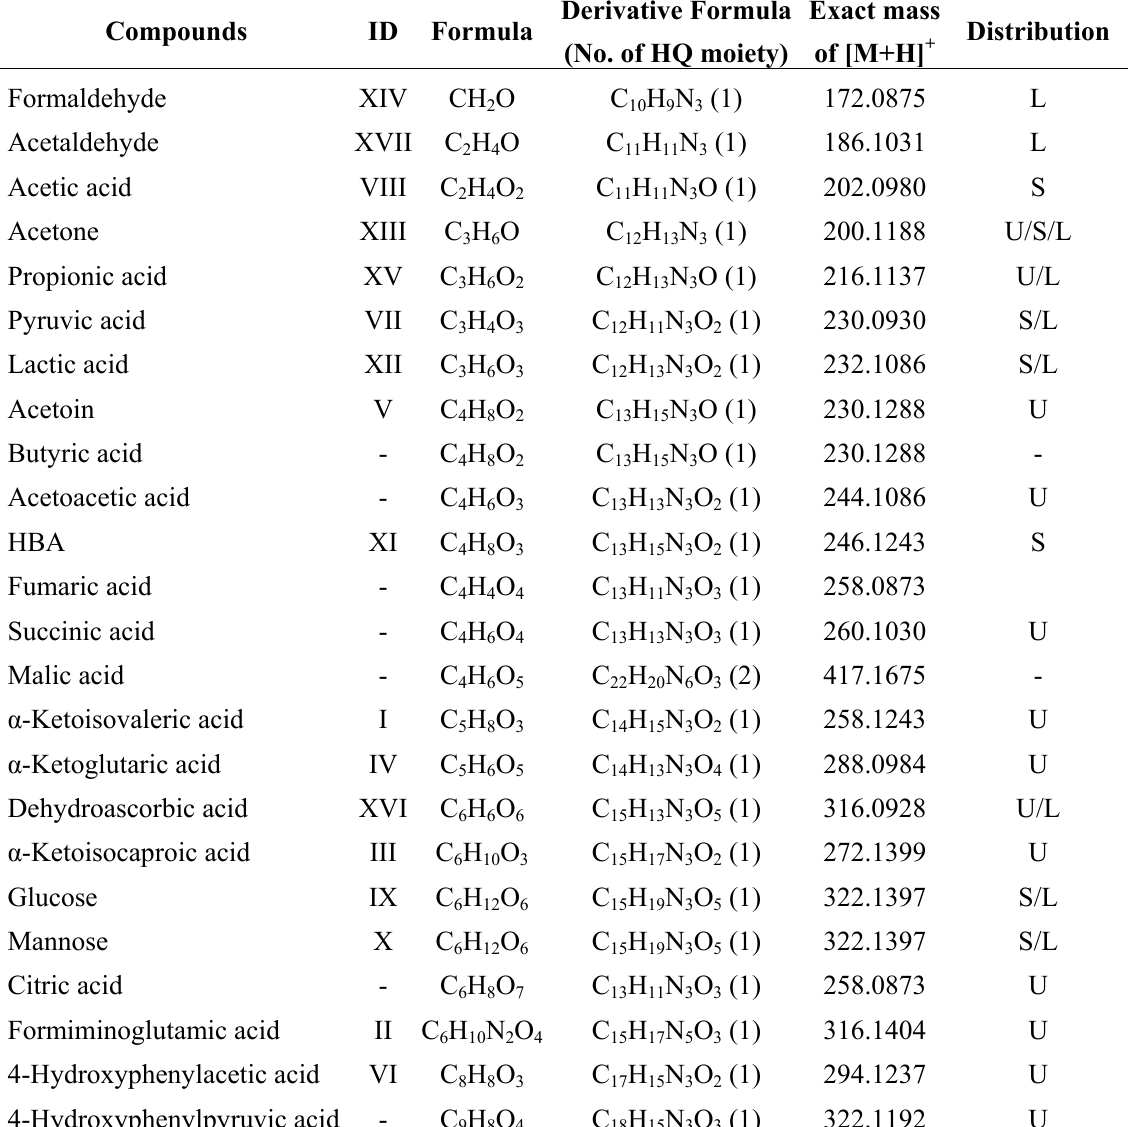
Table 2. A list of confirmed HQ derivatives of carboxylic acid, aldehyde and